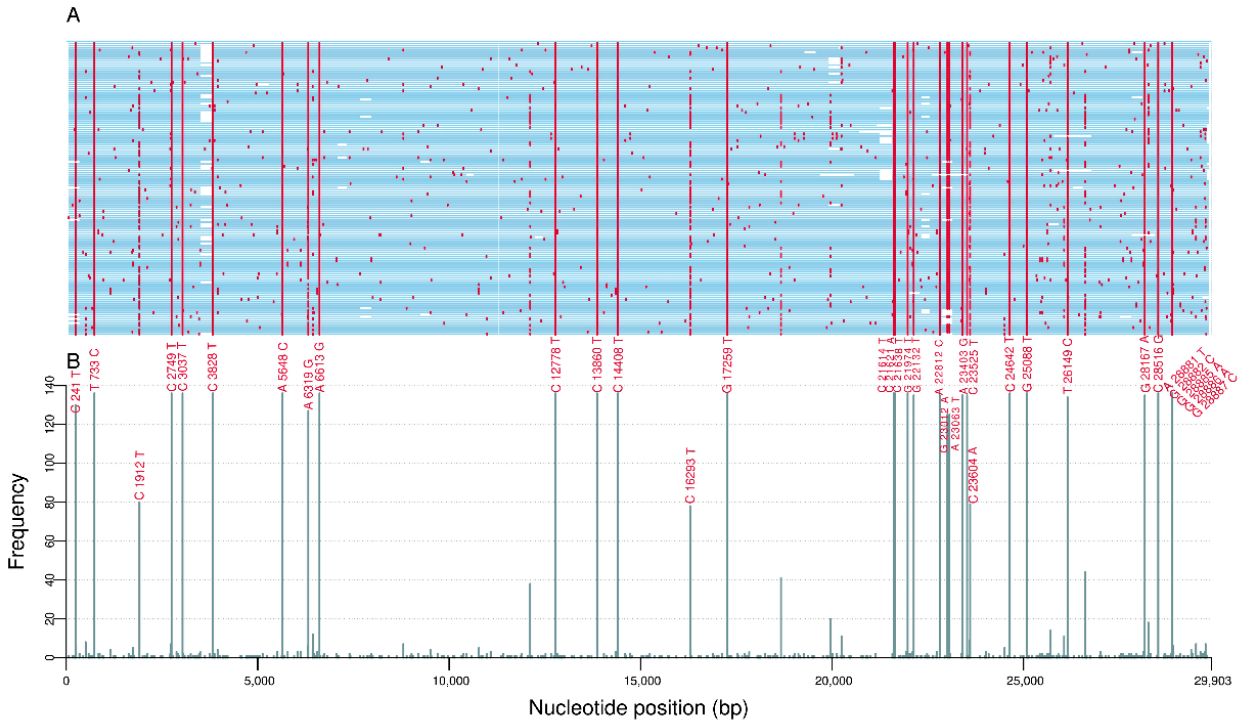
Figure 2. ( A ) Genomic location and ( B ) frequency of single-nucleotide polymorphisms (with respect to the reference genome NC_045512.2) among 136 sequences from VOC Gamma. For the 102 sequences belonging the VOC Delta, 326 different mutations were found, of which 56.1% (183) were non-synonymous, 41.4% (135) were synonymous, 1.2% (4) were intergenic at 5 (cid:48) untranslated region (UTR), 0.6% (2) were intergenic at 3 (cid:48) untranslated region (UTR), and 0.6% (2) were in-frame deletions. Among these mutations, 60.7% (198) were found at ORF1ab followed by spike ( n = 49; 15.0%), nucleocapsid ( n = 26; 8.0%), ORF3a ( n = 15; 4.6%), ORF7a ( n = 14; 4.3%), ORF8 ( n = 8; 2.5%), membrane ( n = 7; 2.1%), envelope ( n = 4; 1.2%), ORF7b ( n = 3; 0.9%), and ORF10 ( n = 2; 0.6%). From the total of mutations, 52.5% (171) were identified in two or more sequences. Highly frequent mutations ( ≥ 50% of genomes) were found in 34 genome positions (Figure 3). From these, 76.5% (26) mutations were non-synonymous, 11.8% (4) were synonymous, 5.9% (2) were intergenic at 5 (cid:48) untranslated region (UTR), and 5.9% (2) were in-frame deletions. Remarkably, seven non- synonymous mutations were located in the S gene (T19R, G142D, L452R, T478K, D614G, P681R, and